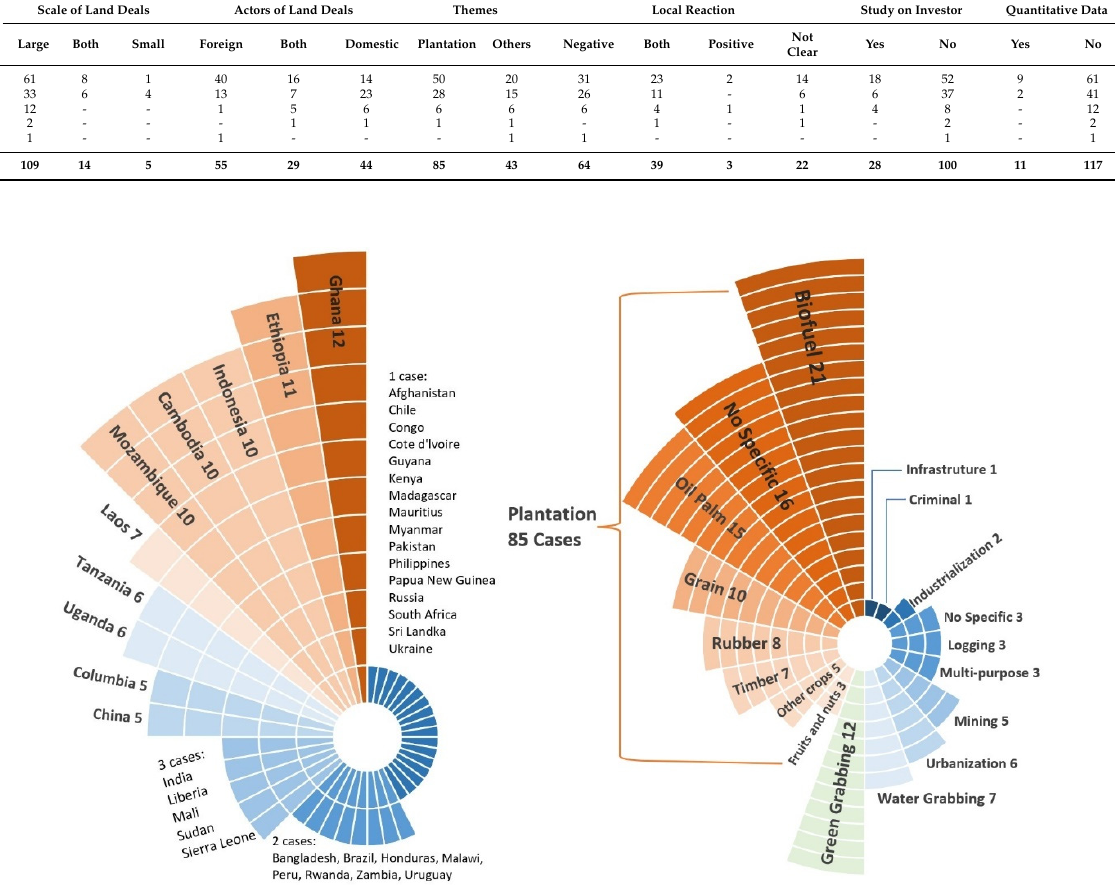
Figure 2. Case locations by country and grabbing types ( n = 128).